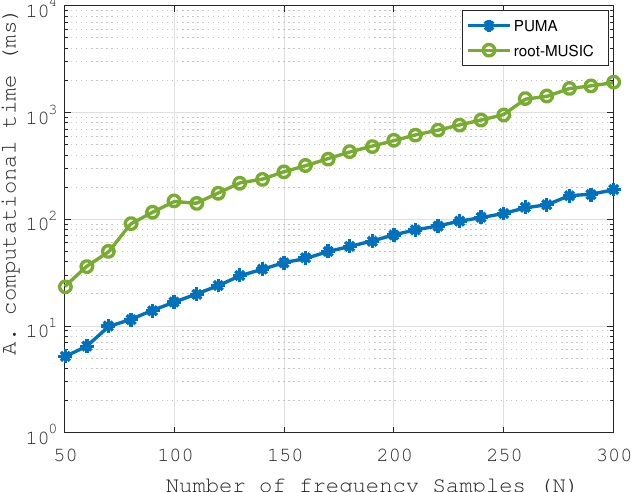
Figure 9. Average computational time versus the number of samples ( N ), fully uncorrelated signals, K = 3, SNR =